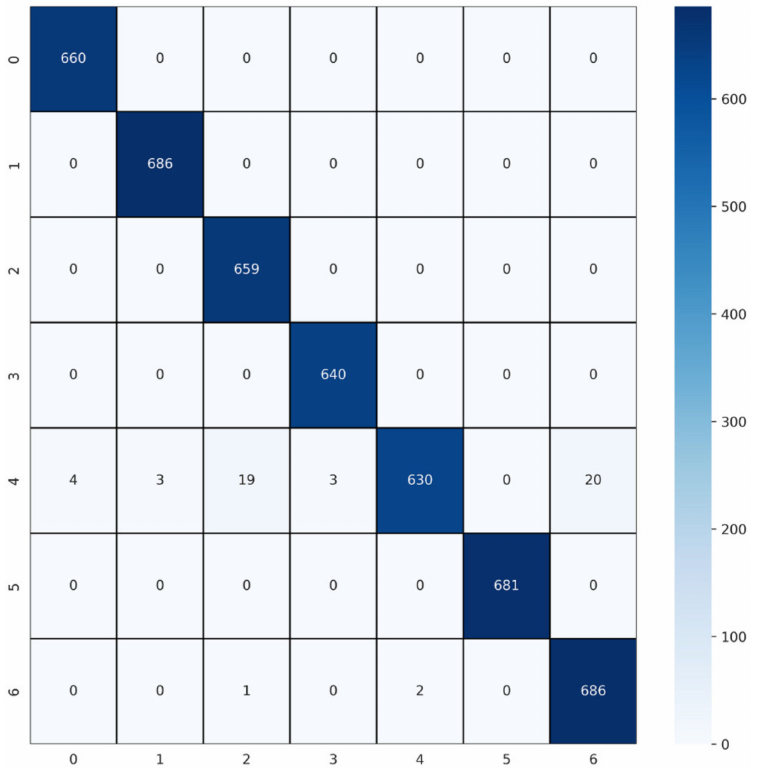
Figure 12. Confusion matrix for